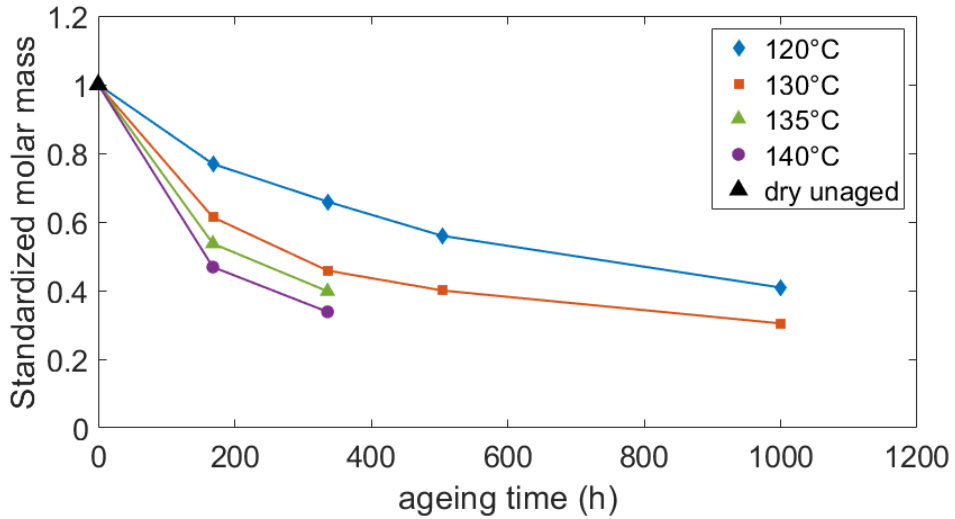
Figure 4. Reduction of the average molar masses due to the hydrolysis and/or oxidation reaction during the ageing processes.